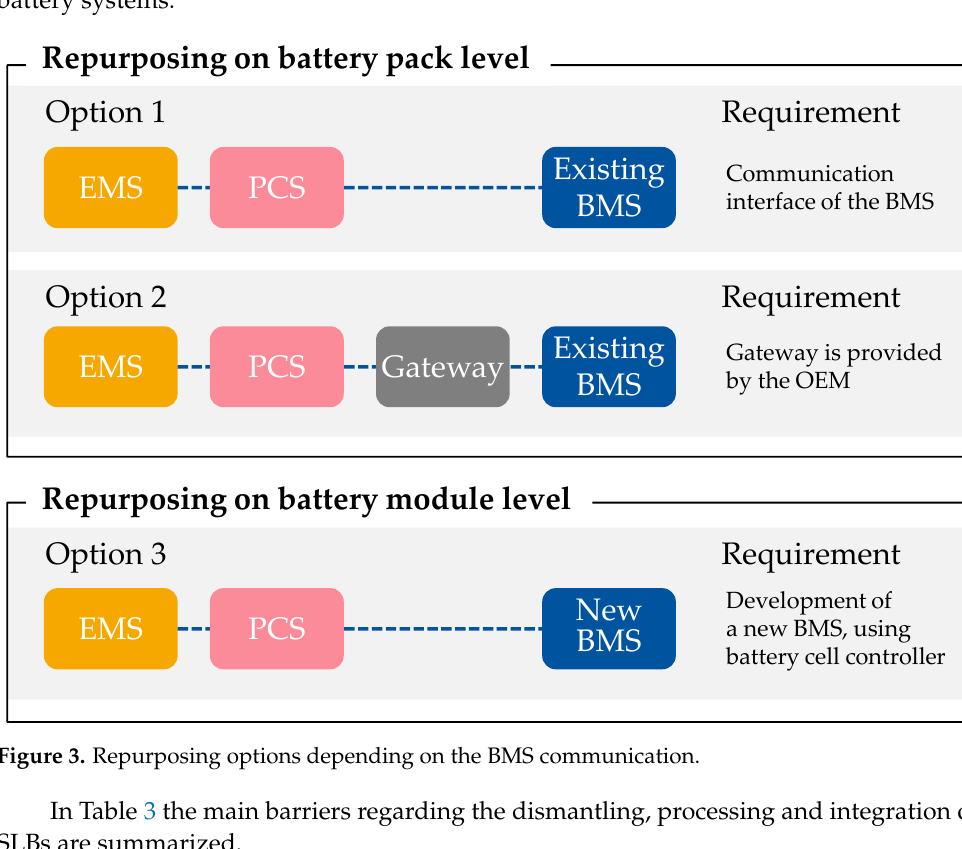
Table 3. The main barriers regarding Dismantling and Processing. Individual